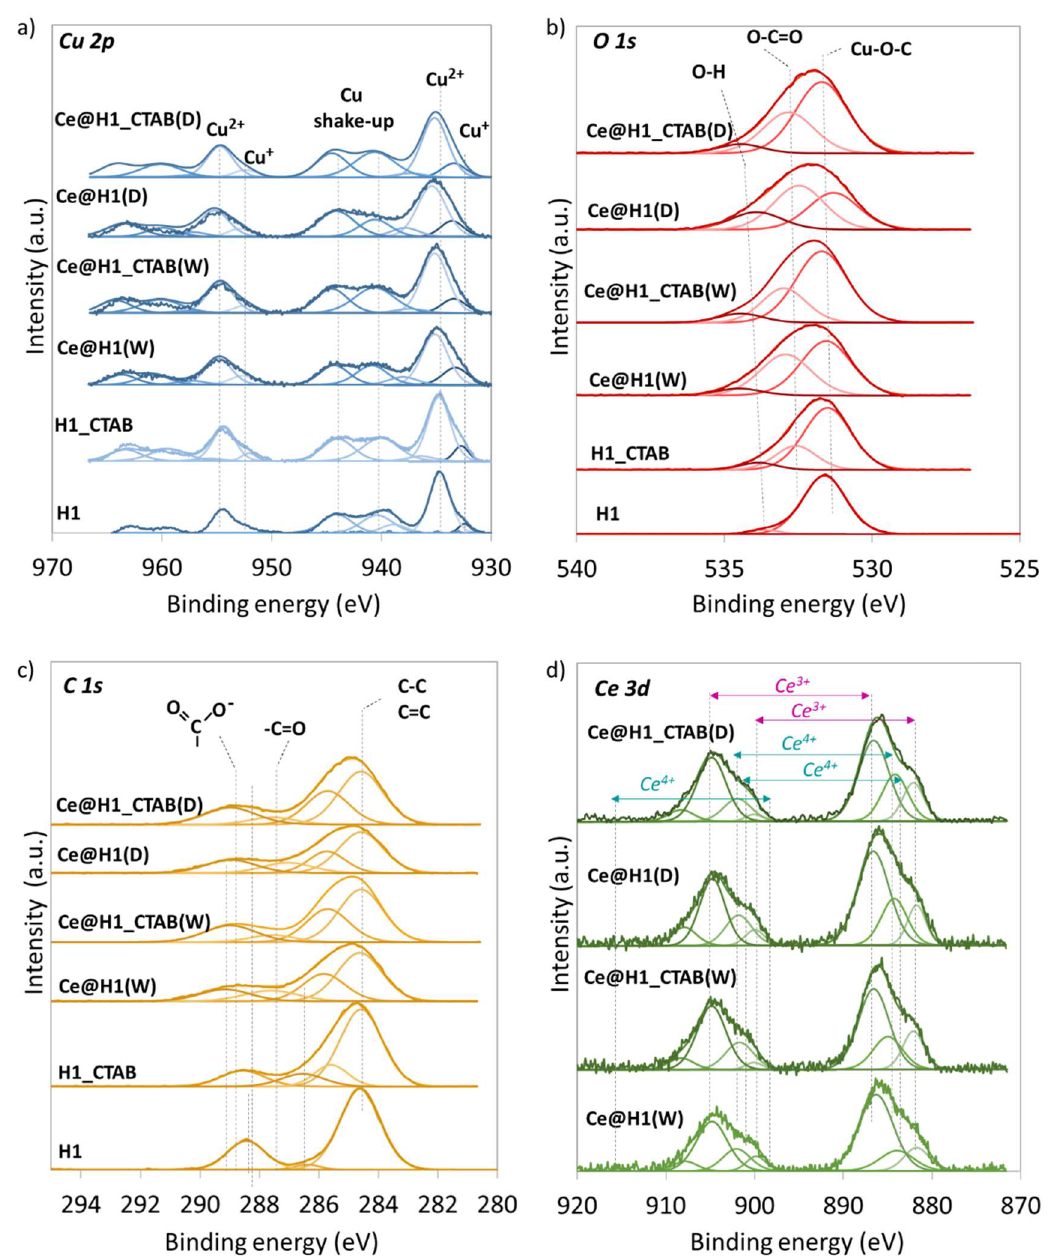
Figure 7. XPS Cu 2p ( a ), O 1s ( b ), C 1s ( c ) and Ce 3d ( d ) spectra of HKUST-1 and Ce@HKUST-1 materials.